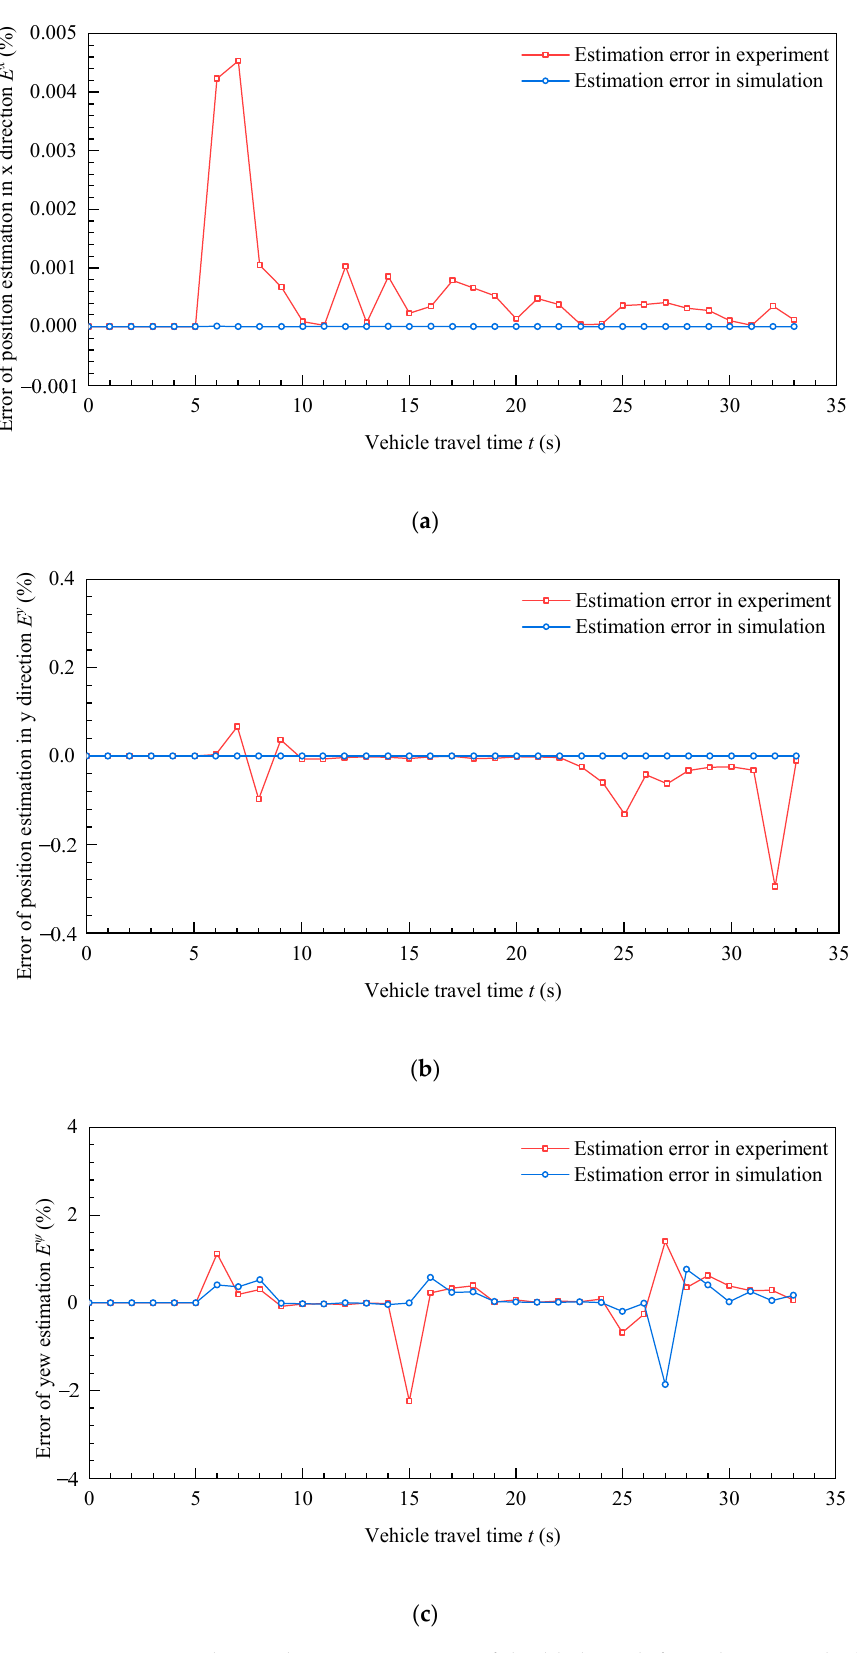
Figure 10. Position and attitude estimation error of double lane shifting driving path. ( a ) Position estimation error in x direction. ( b ) Position estimation error in y direction. ( c ) Yaw estimation